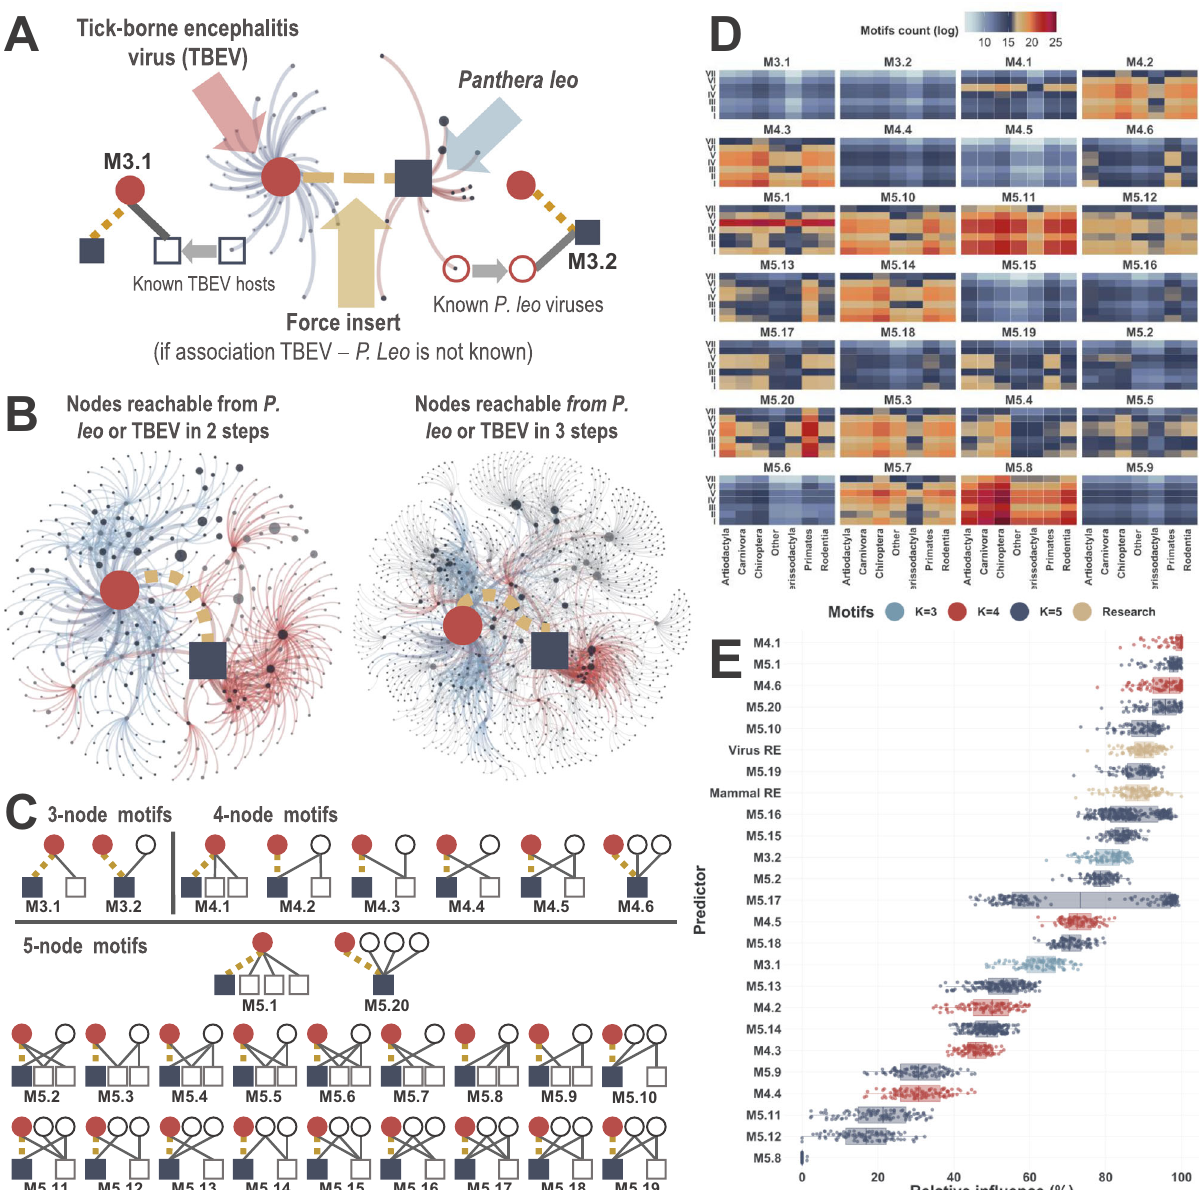
Fig. 4 The network perspective - potentia l motifs (subgraphs) in our virus-host bipartite network. A The concept of potential motif. The association TBEV- P. leo is a forced insertion into the network prior to calculating motifs for the association. B Motifs space: networks represent 2 steps and 3 steps ego networks (union) of host (here P. leo ) and virus (TBEV). 1, 2 and 3 step ego networks comprise the counting space for TBEV- P. leo potential motifs. Dark grey nodes represent viruses, light grey nodes represent hosts. Size of nodes is adjusted to represent overall number of hosts or viruses with known associations to the node. Red edges represent nodes reachable from the mammal ( P. leo ) in 1 or 2 steps (links). Blue edges represent nodes reachable from the virus (TBEV) with 1 or 2 steps (links). Humans and rabies virus were excluded from these networks. C 3, 4 and 5-node potential motifs in our virus-host bipartite network. Circles represent viruses and squares represent mammals. Red circles represent the focal virus (v), and blue squares represent the focal mammal (m) of the association v-m for which the motifs are being counted (dashed yellow line). This association has two states: either already known (documented in EID2), or unknown. Grey lines illustrate existing associations in our network. D Motifs counts. Heatmap illustrating distribution of motif- features (counts of potential motifs per each focal association) in our bipartite network, grouped by mammalian order and Baltimore classi fi cation. The counts are logged to allow for better visualisation. E Variable importance (relative contribution) of motif-features (variables) to our network perspective models (SVM-RW). Motifs (subgraphs) are coloured by the number of nodes ( K = 3, 4, 5). Boxplots indicate median (centre), the 25th and 75th percentiles (bounds of box) and inter quantile range (whiskers). Points represent variable importance in individual runs ( n = 100). Research effort into both viruses and mammals is included as independent variables in our network models (coloured in